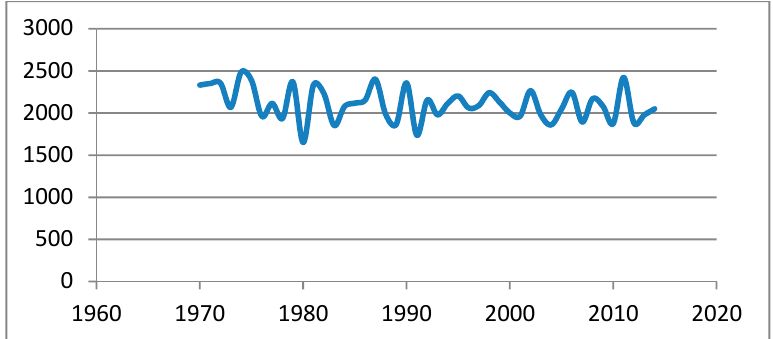
Figure 5. Rainfall pattern in MADA area, Malaysia, 1970–2014. Table 2. Correlation